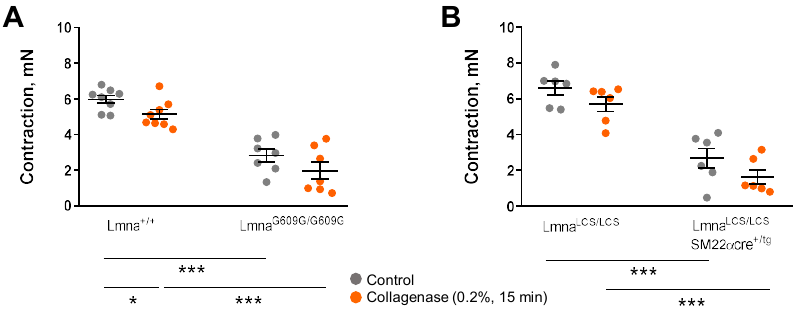
Figure 4. Collagen disruption by collagenase does not rescue contractile impairment in progerin-expressing mice. Wire myography experiments to test the effect of 15 min incubation with 0.2% collagenase on contractile responses induced by 120 mM KCl in aortic rings. ( A ) Lmna G609G/G609G mice and wild-type controls ( Lmna +/+ ). ( B ) Lmna LCS/LCS SM22α tg/+ mice and Lmna LCS/LCS controls. Statistical differences were analyzed with two-way ANOVA followed by the Sidak multiple comparison test. * p < 0.05; *** p < 0.001.